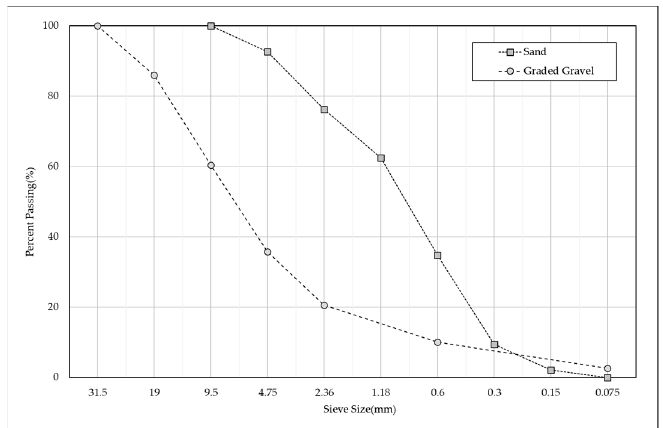
Figure 2. Experimental results of sieving sand and graded gravel.